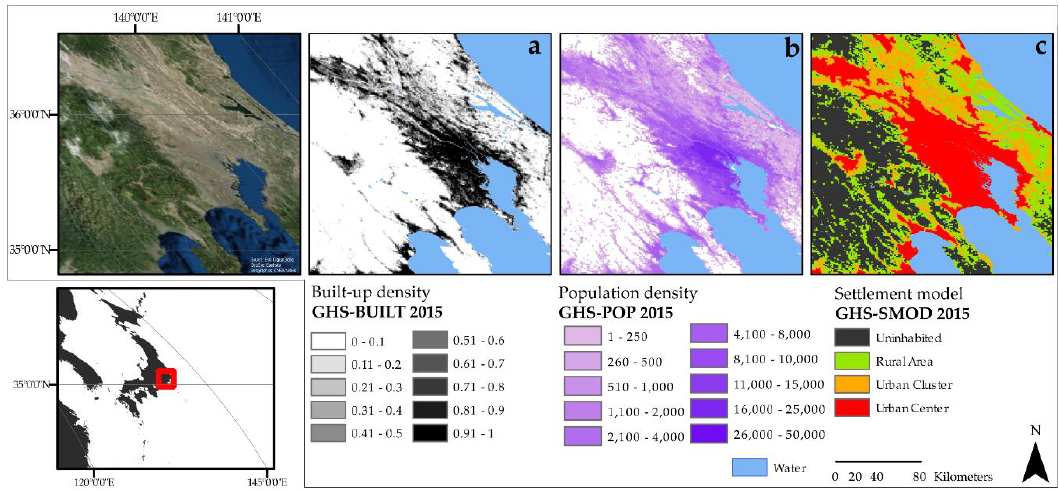
Figure 1. Example of GHSL data, three geospatial layers that map built-up areas (GHS-BUILT) ( a ), three geospatial layers that map resident population (GHS-POP) ( b ), three geospatial layers that map settlement typologies (GHS-SMOD), and ( c ) displayed at 1km spatial resolution in the area of Tokyo (Japan) and compared to the imagery base map.